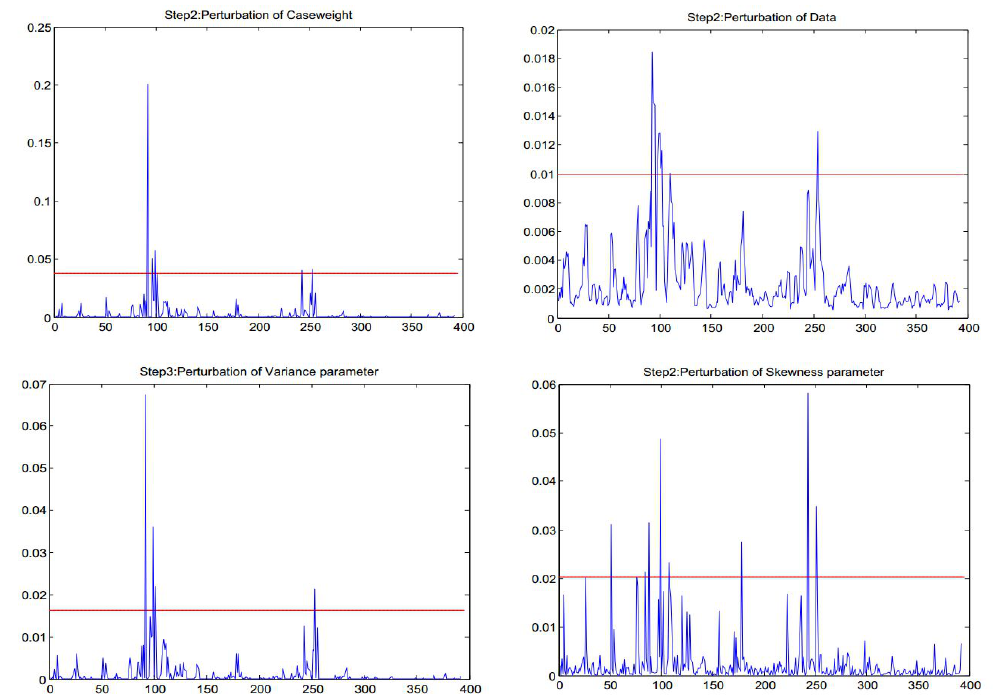
Figure 5. Diagnostics for the perturbations of case-weights, data, variance, and skewness in the SN AR(3) model [step